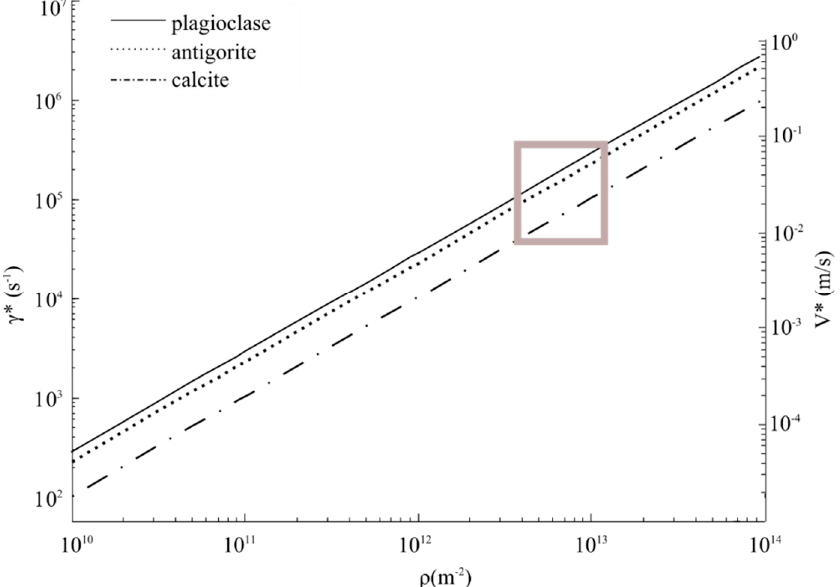
Figure 5. The fast moving dislocation model predicts the existence of a critical strain rate that determines the transition from ductile to brittle behavior. The critical strain rate depends on the dislocation velocity. The box indicates the region where dynamic weakening was observed in fault rocks deformed at seismic slip rates. The slip rate is calculated from the strain rate assuming a slipping zone deformation thickness of 0.5 µm, consistent with the microstructural observations in the case of experiments performed on Carrara marble, Figure 2a).